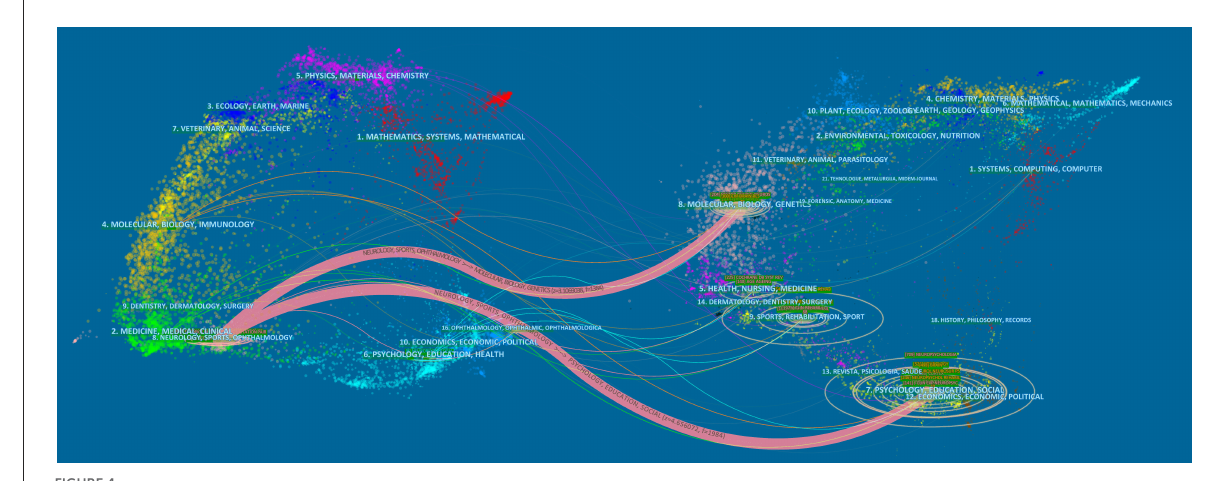
FIGURE5 The number of articles, open-access articles, citations, H-index, and citations per paper of the top 15 subject categories of Web of Science.